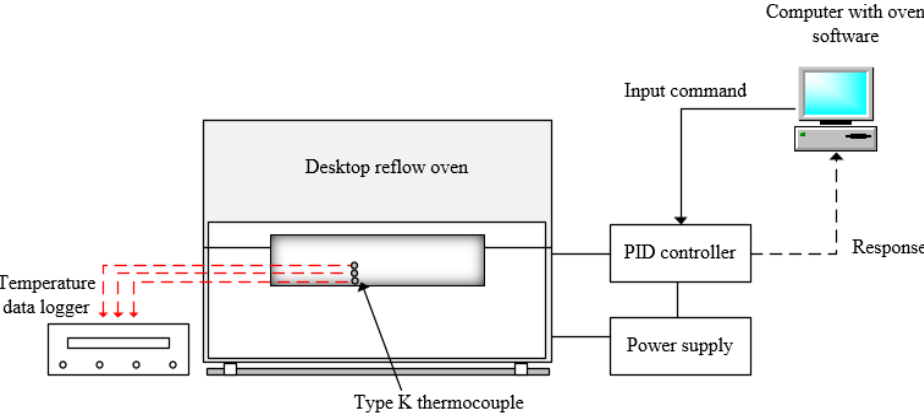
Figure 4. Schematic diagram of the desktop reflow oven.